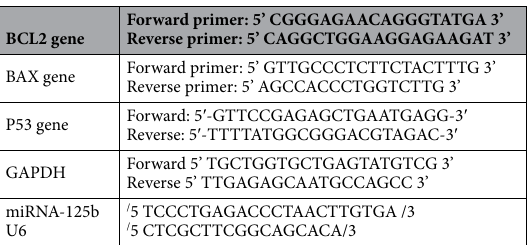
Table 7. The oligonucleotide primers sequence of studied genes for BCL2, BAX, P53 & miRNA-125b.